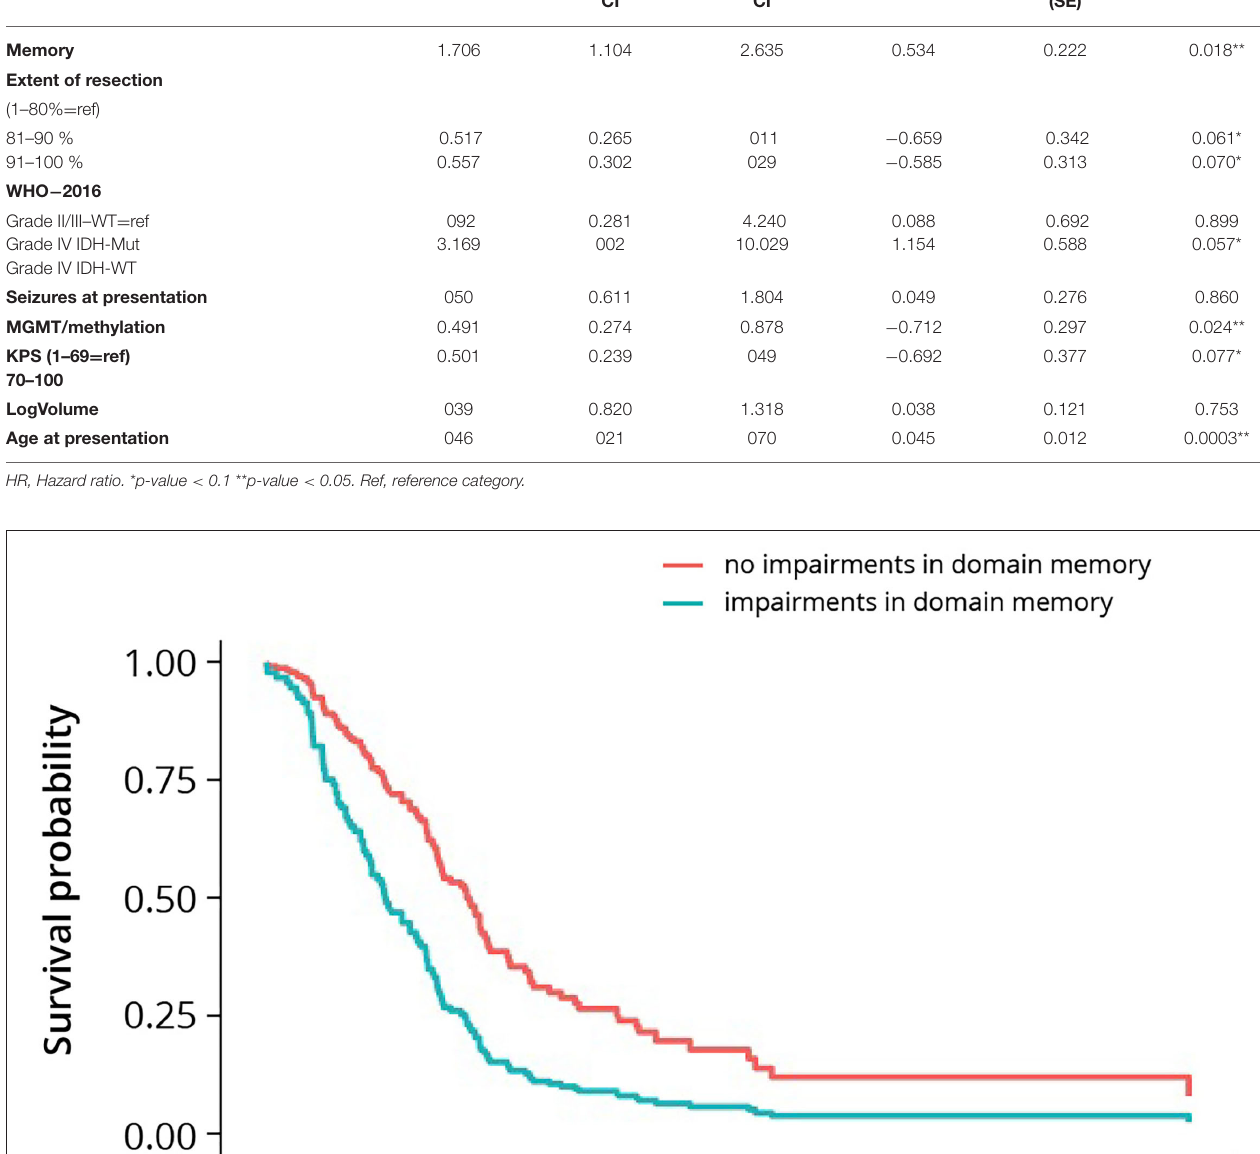
TABLE 5 | Multivariable cox-regression model with memory included in high-grade glioma. Variable